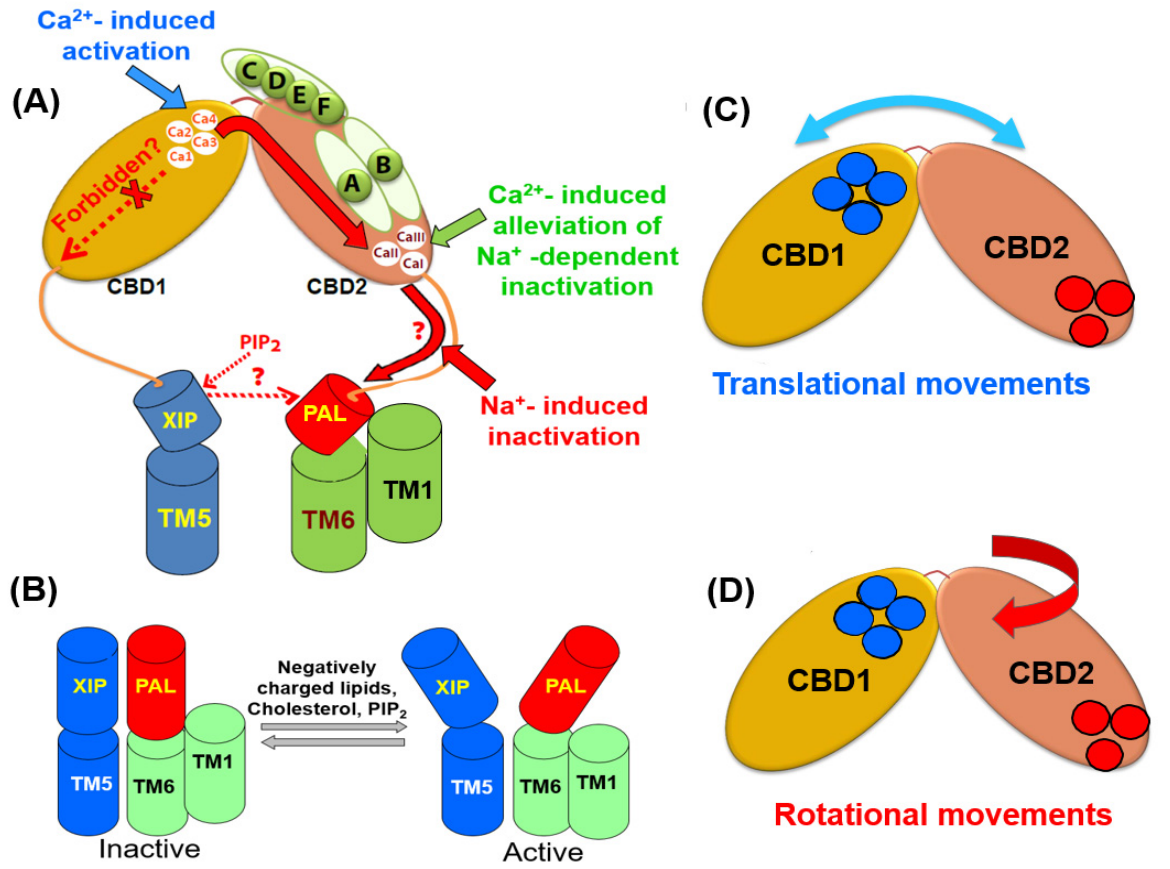
Figure 7. Structural elements that contribute to the propagation and integration of allosteric signals. ( A ) The occupation of the Ca3-Ca4 sites by Ca 2+ rigidifies the backbone dynamics at the two-domain interface of CBDs. The allosteric signal propagation from the C-terminal tip of CBD1 to the C- terminal end of CBD2 (shown in a solid red arrow) is under the control of the splicing segment at CBD2 and the two-domain interface. ( B ) The positively charged XIP (autoinhibitory) domain can anchor the negatively charged helix (PAL) at the palmitoylation site. Since the PAL domain links to TM6, the XIP/PAL unit may affect the sliding of the TM1/TM6 bundle, thereby modulating the transport rates. The interactions of inhibitory (e.g., Na + ) and activating (e.g., PIP 2 ) ligands with respective sites (located of the XIP/PAL unit) can shift a steady-state equilibrium between the active and inactive states. Blue and red cylinders represent the XIP and PAL domains, respectively. The interdomain movements of the CBD1 and CBD2 domains might involve translational ( C ) and rotational ( D ) movements. Specific structural elements (e.g., the two-domain interface, XIP/PAL unit, and varying exon compositions) may characteristically shape the outcomes of regulatory specificity in a given NCX variant by controlling a relationship between the translational and rotational movements. The blue and red cycles represent the Ca 2+ binding sites of CBD1 and CBD2,